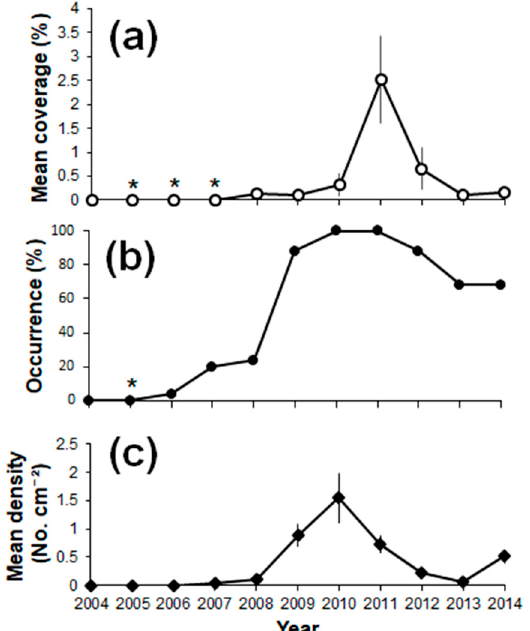
Figure 2. Temporal changes in ( a ) coverage on control plots, ( b ) occurrence (presence or absence) on control plots, and ( c ) annual recruitment density on recruitment plots for Balanus glandula in eastern Hokkaido during 2004–2014. Vertical bars indicate standard errors. Asterisks (*) indicate that no B. glandula were detected.